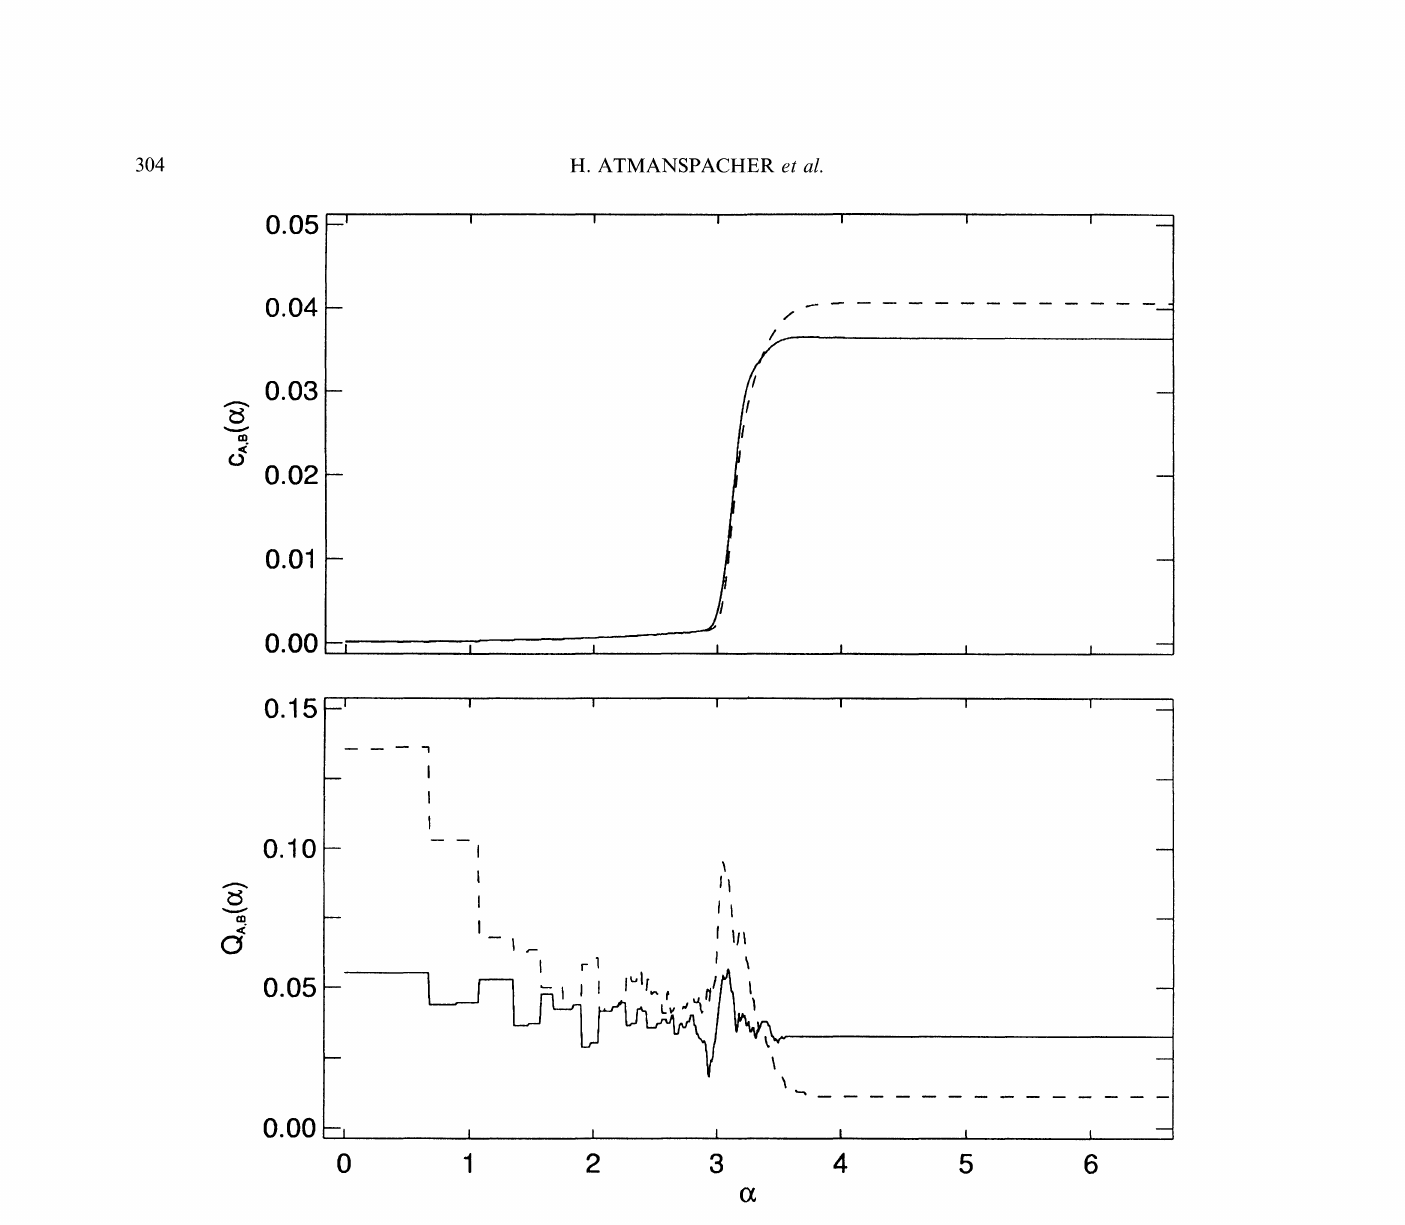
FIGURE 4 Upper panel: deviation profile c(c0 for the two Versions (A) (dashed line) and (B) (solid line) of Section 2.2 with 3’ 2. Lower panel: the pointwise profile crossing probabilities QA (dashed line) and Q (solid line) are the relative frequencies with which Mc,l,(c0 exceeds the deviation profile of the upper panel for a single value